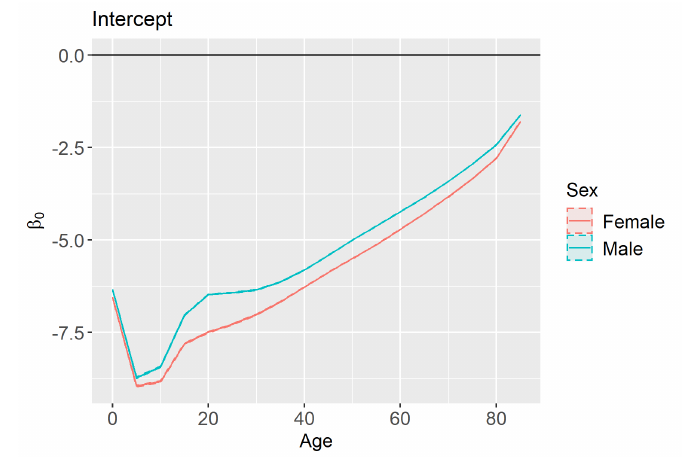
Figure 6. Estimates and 95% credible intervals for β 0 (intercept) by sex and